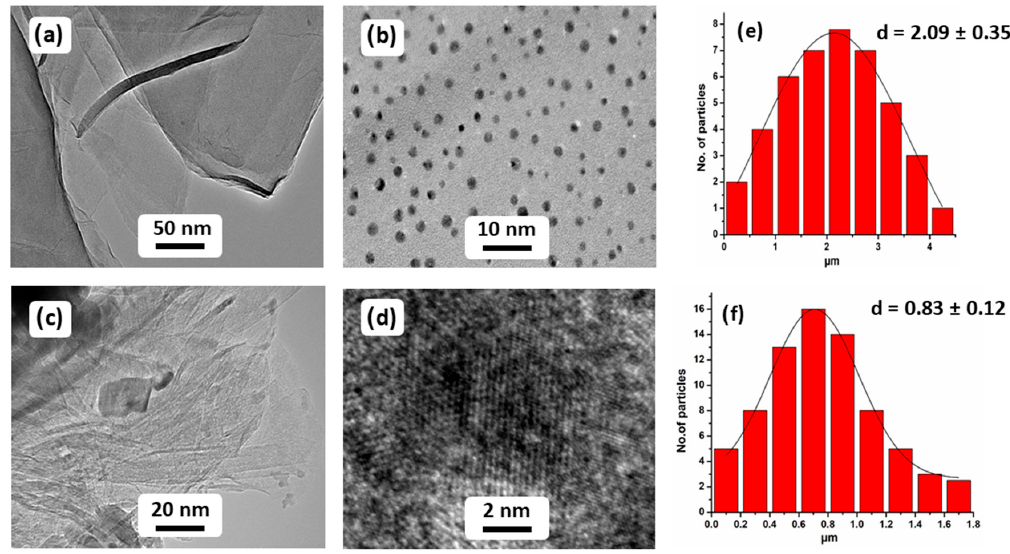
Figure 4. HR-TEM images of ( a ) GRO, ( b ) (1%)Ag 2 O–MnO 2 catalyst (without GRO), ( c , d ) (1%)Ag 2 O– MnO 2 /(5 wt.%)GRO nanocomposite, ( e , f ) particle size distribution of (1%)Ag 2 O–MnO 2 and (1%)Ag 2 O–MnO 2 /(5 wt.%)GRO nanocomposite,